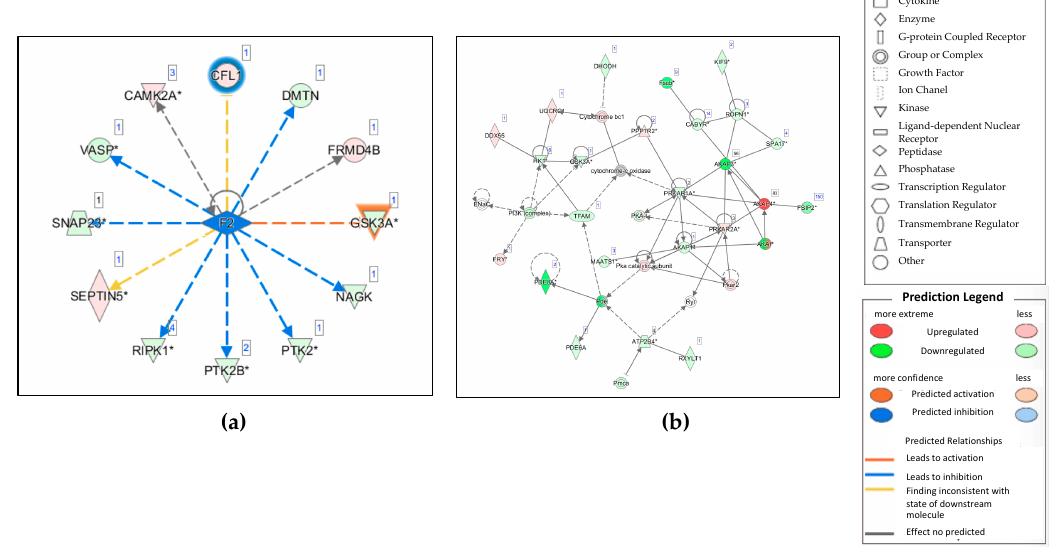
Figure 4. ( a ) Upstream regulators and their corresponding inhibition as predicted by IPA. F2 was predicted to be inhibited (z-score − 2.147 and p -value 0.011). In this picture, activated upstream regulators are highlighted in orange, while inhibited upstream regulators are in blue. Colors in red and green indicated upregulated and downregulated proteins, respectively, and the color depth is correlated to the fold change. Dashed lines with arrows in orange and blue indicate indirect activation and inhibition, respectively. Yellow dashed lines with arrows indicated inconsistent e ff ects, while gray dashed lines with arrows indicated no prediction. ( b ) IPA-based network of proteins involved in cell signaling, cellular movement, and reproductive system development and function for the Cap 60 / 0 datasets. In the figure, red represents upregulation and green represents downregulation. The color intensity represents the relative magnitude of the change in protein expression. Direct and indirect interactions are indicated by solid and dashed lines, respectively.